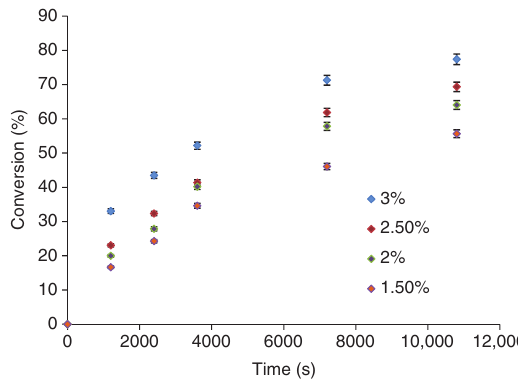
Figure 8 Effect of catalyst loading on the percentage conversion.